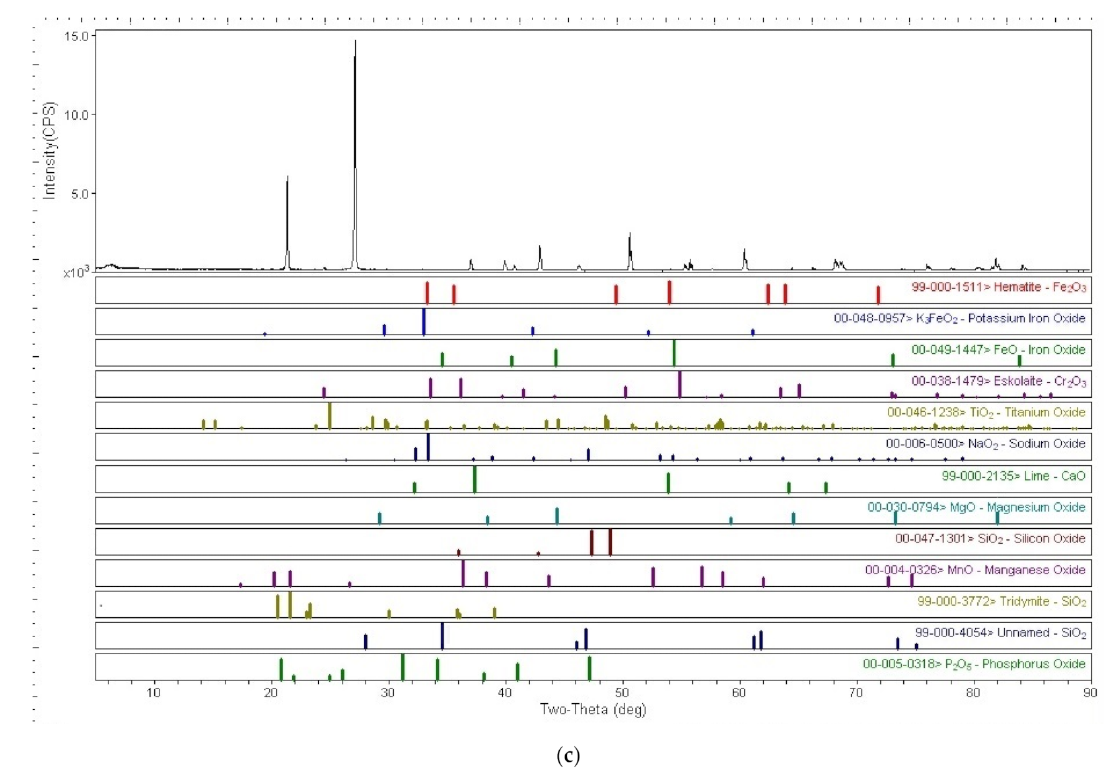
Figure 9. The powder analysis result pictures: ( a ) scanning electron microscope image of the powder; ( b ) Elemental compo- sition spectrum of the powder; ( c ) X-ray diffraction intensity (cps–count per seconds) distributions for the powder